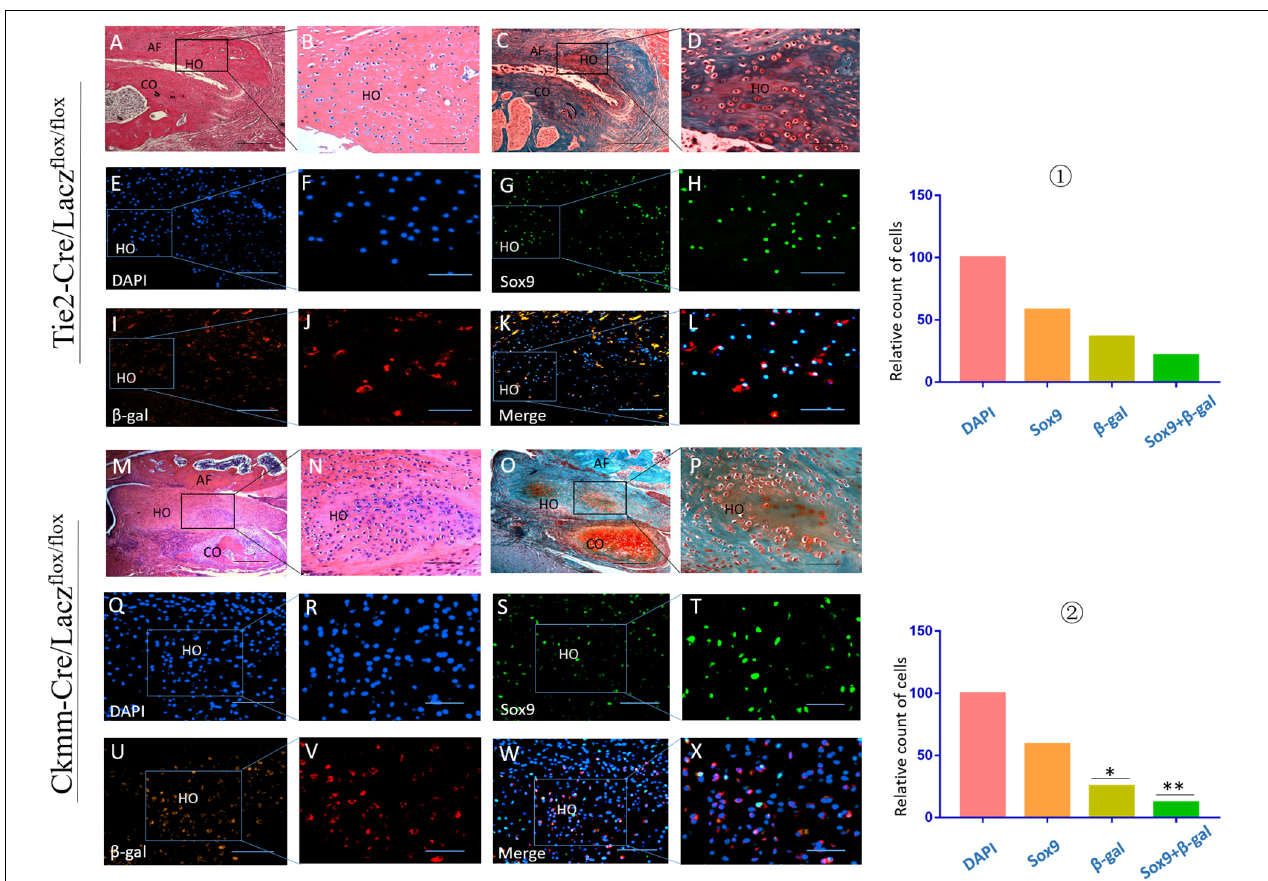
FIGURE 9 | Precursor cell lineage tracing in THO-TMJ. H&E examination (A,B,M,N) and safranin O and fast green examination (C,D,O,P) revealed the structure of the TMJ, which suffered from obvious HO. (E–L) Precursor cell lineage tracing in heterotopic ossification tissues in the Tie2-Cre/Lacz flox / flox THO-TMJ mouse model. (Q–X) Precursor cell lineage tracing in heterotopic ossification tissues in the Ckmm-Cre/Lacz flox / flox THO-TMJ mouse model. (E,F,Q,R) DAPI staining. (G,H,S,T) Sox9 staining. (I,J,U,V) Immunofluorescence staining of β -gal. (K,L,W,X) Merged images of DAPI, Sox9, and β -gal. (cid:172) The relative cell counts of different markers in Tie2-Cre/Lacz flox / flox THO-TMJ mice, with the count of DAPI regarded as 100 and the counts of other markers calculated and compared with the count of DAPI. (cid:173) The relative cell counts of different markers in Ckmm-Cre/Lacz flox / flox THO-TMJ mice showed fewer β -gal-positive cells and β -gal/Sox9 costained cells than observed in Tie2-Cre/Lacz flox / flox THO-TMJ mice (* p < 0.05, ** p < 0.01). Panels (B,D,F,H,J,L,N,P,R,T,V,X) are local magnifications of the boxed areas in panels (A,C,E,G,I,K,M,O,Q,S,U,W) . AF, articular fossa; CO, condyle; HO, heterotopic ossification. Scale bar: (A,C,M,O) , 200 µ m; (B,D,E,G,I,K,N,P,Q,S,U,W) , 50 µ m; (F,H,J,L) , 25 µ m; (R,T,V,X) , 20 µ